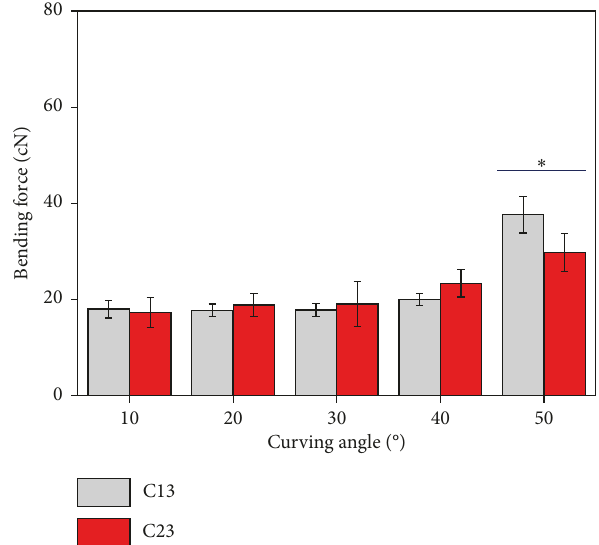
Figure 6: Bending force of stent grafts A11, A22, and A33 given the same curving angle.